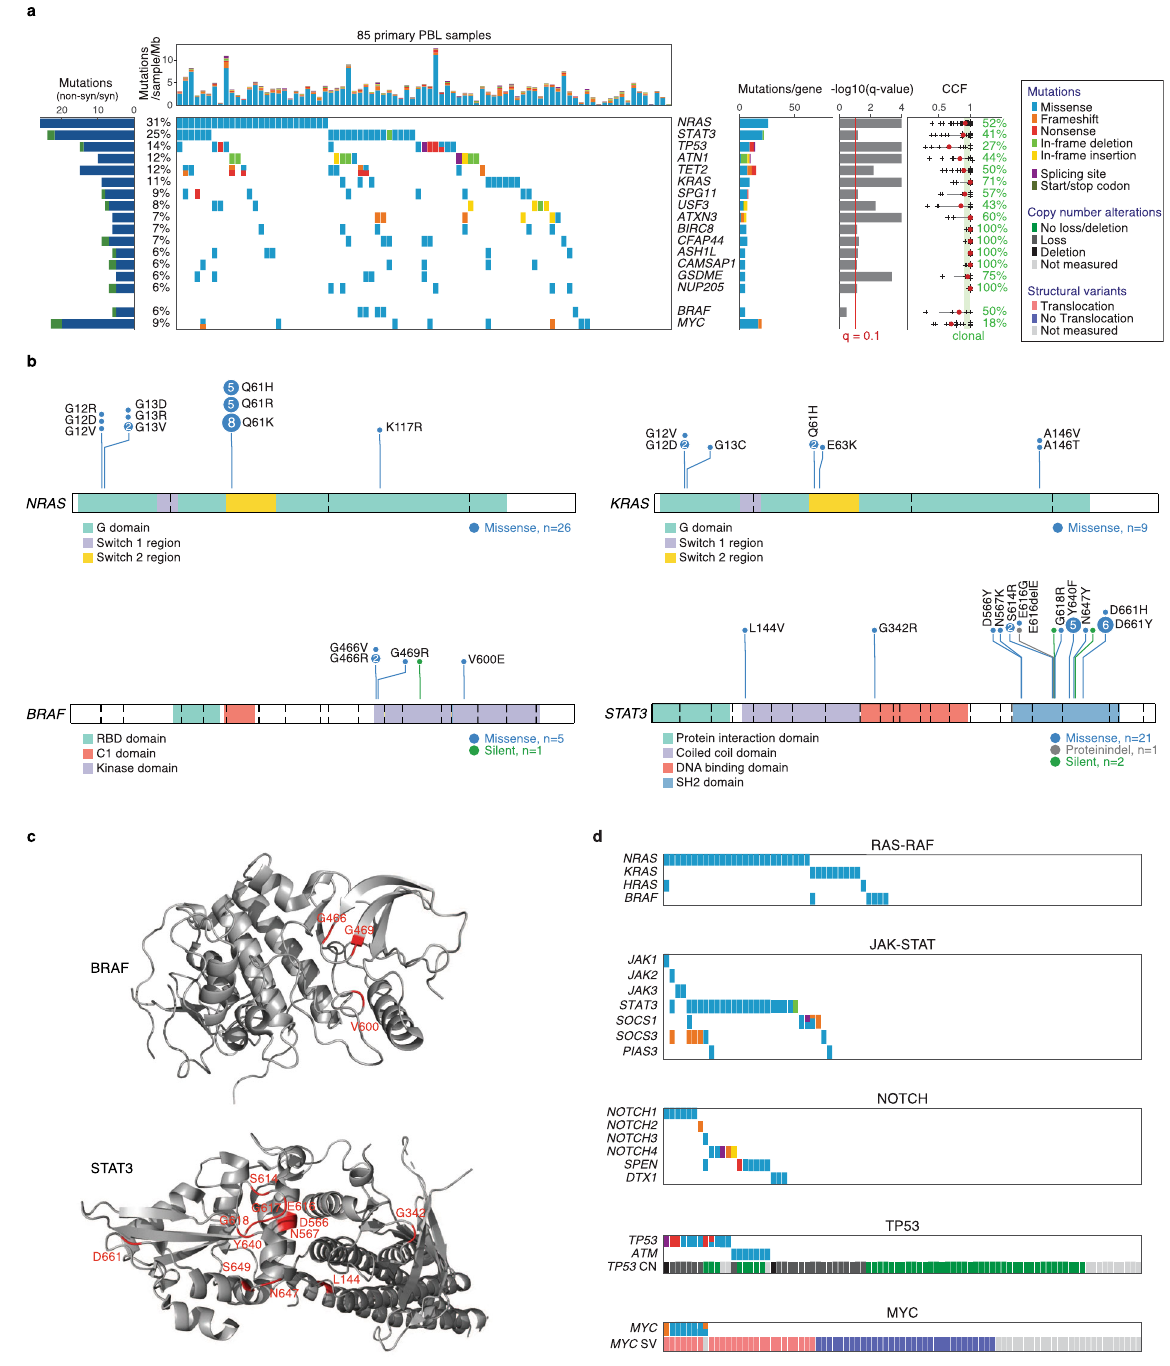
Fig. 1 Landscape of somatic mutations in PBL determined by WES. a All called non-synonymous mutations in signi fi cant genes according to MutSig2CV v3.11 ( q M2CV < 0.1, cohort frequency (cid:1) 5%) are color-coded and shown for each PBL sample per column, ranked by cohort frequency (see Supplementary Data 3 and 4 for all results). Samples are ordered by waterfall sorting based on binary gene mutation status. The bar graph on the left shows the ratio of non-synonymous (blue) and synonymous (green) mutations per gene. At the top, the TMB per sample (mutations/sample/Mb) is depicted. On the right, occurring types of mutation and q values (M2CV) are shown per gene. For each gene, the CCF (fraction of cancer cells having a mutation in at least one allele) was estimated for samples with corresponding copy number measurement (median in red). Clonality was assumed for CCF (cid:1) 0.9. The percentage of samples with clonal mutations is indicated per gene. b The distribution of detected mutations on protein level for the selected CCGs NRAS (NM_002524), KRAS (NM_033360), BRAF (NM_004333), and STAT3 (NM_139276). Exon boundaries are indicated using dashed lines. c Spatial clustering of mutations within the protein structures of BRAF (PDB 6nyb) 95 and STAT3 (PDB 6njs) 96 . d Co-occurrence of mutations belonging to selected biological pathways. For each analyzed pathway, samples are presented in their corresponding waterfall sort order by binary gene mutation status. Copy number (CN) and translocation status (SV) are depicted for TP53 and MYC , respectively.